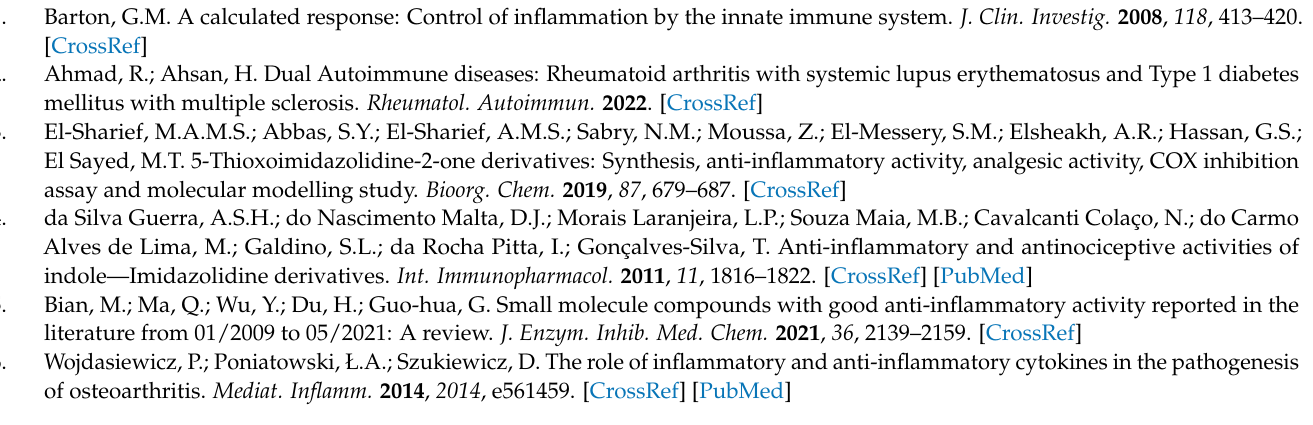
d 6 ; Figure S3. 1 H-NMR and 13 C-NMR spectra of compound 5 in DMSO- d 6 ; Figure S4. 1 H-NMR and 13 C-NMR spectra of compound 6 in DMSO- d 6 ; Figure S5. 1 H-NMR and 13 C-NMR spectra of compound 7 in DMSO- d 6 ; Figure S6. 1 H-NMR and 13 C-NMR spectra of compound 8 in DMSO- d 6 ; Figure S7. Western plot analysis of the in vitro anti-inflammatory effect of compound 7 against LPS- activated RAW264.7 cell line on IL-1 β expression; Table S1: In vitro cytotoxicity of 1,3 disubstituted-2- thioxoimidazolidin-4-one derivatives against LPS-induced RAW264.7; Table S2: Effect of compound 7 on IL-6 and TNF- α expression in RAW264.7 by RT-PCR; Table S3: In vitro effect of compound 7 on Western blot analysis of IL-1 β in RAW264.7